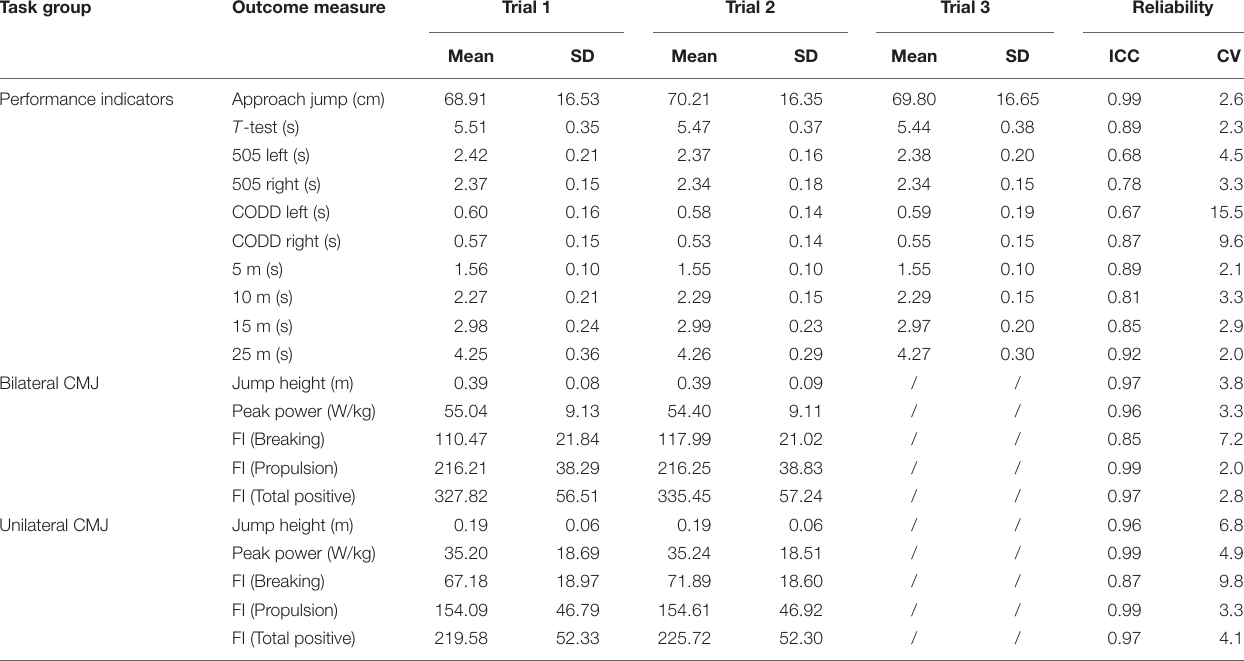
TABLE 1 | Descriptive statistics and reliability for all outcome variables. Task group Outcome measure Trial 1 Trial 2 Trial 3